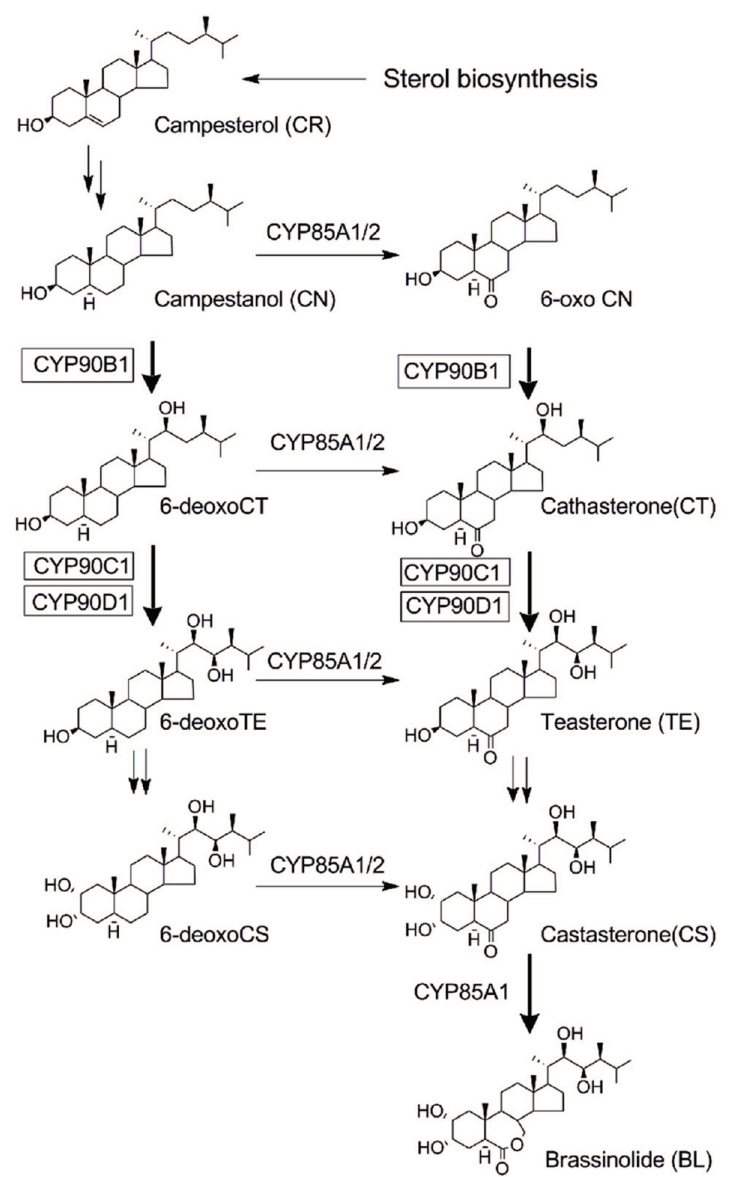
Figure 1. The CYP450s involved in brassinosteroids